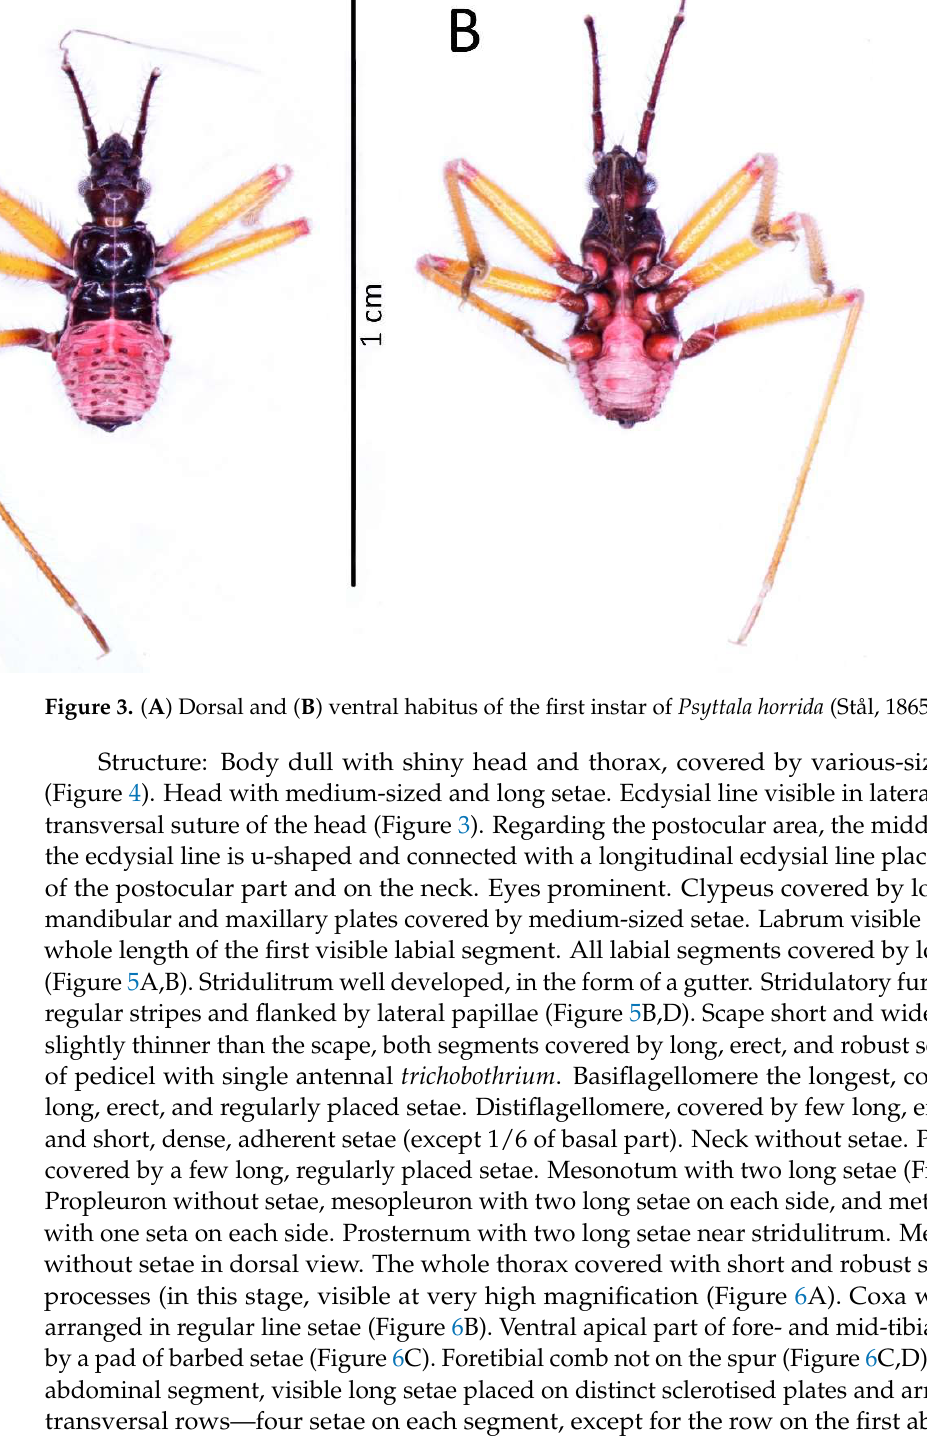
brownish-red trochanter. Femur yellow with brownish-red basal and red apical part, cov- ered with light brown setae. Tibia yellow with red basal and pale brown apical part, cov- ered with yellowish setae. Tarsus pale brown. Abdomen red to dark pink with black scle- rotised muscle attachments and plates on the dorsal part. Tip of the abdomen dark brown to black (Figure 3).